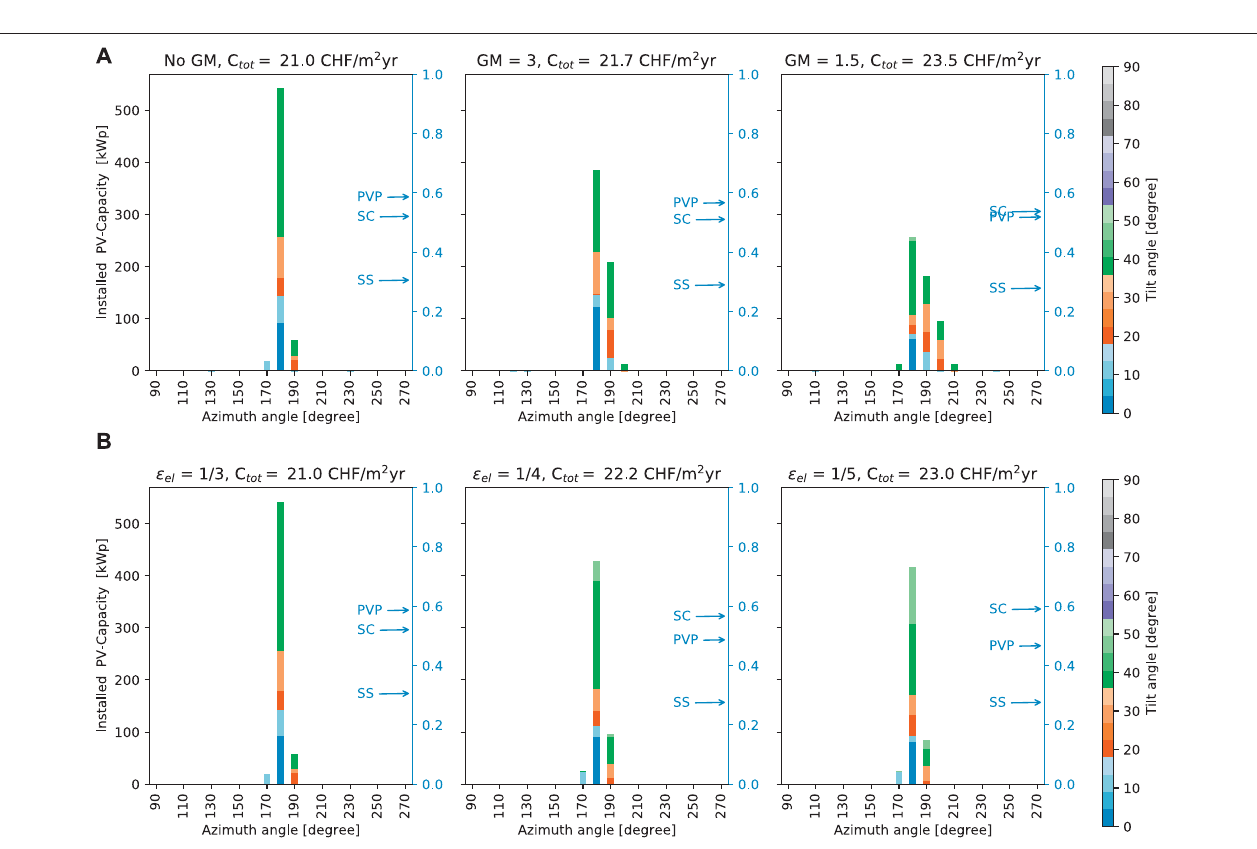
FIGURE 13 | Distribution of PV installation and orientation for total cost optimization of 40 buildings with individual load pro fi les. Assumption of fl at roof with unconstrained orientation possibilities. (A) Three different grid constraints. (B) Three different electricity price shares ϵ el (cid:2) feed-in tariff/electricity price.